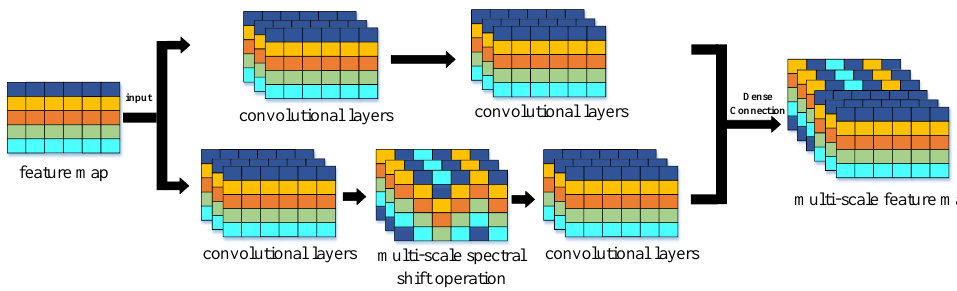
Figure 4. Multi-scale spectrum shift dense neural module.